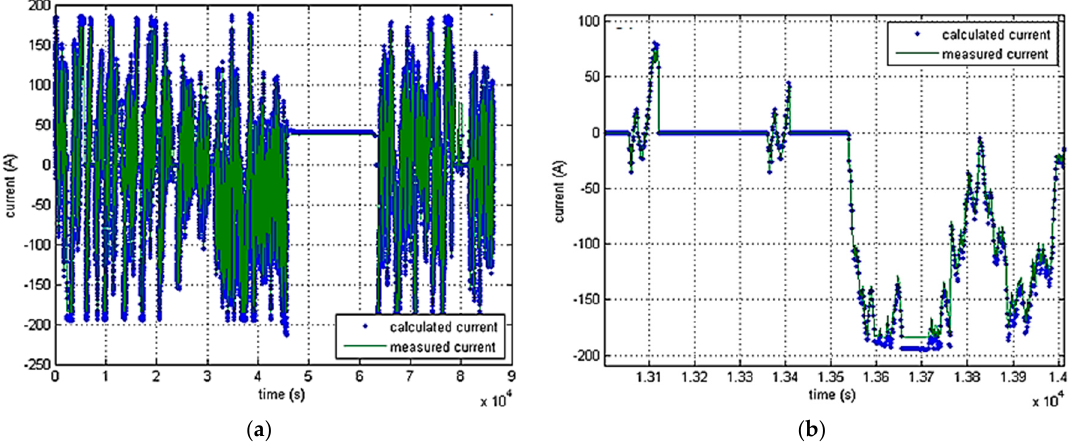
Figure 10. PFC tests, measured and calculated battery current vs. time: ( a ) current vs. time during 1 day; and ( b ) detail in the time range 13,000–14,000 s.